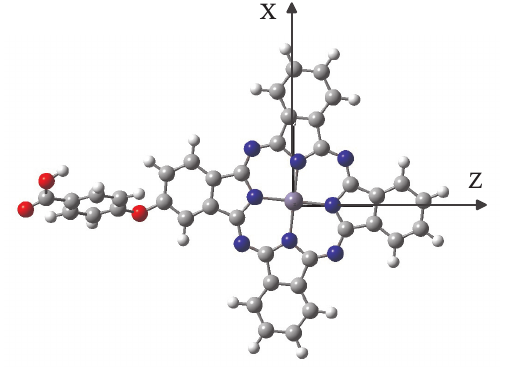
Figure 3. The polar molecular complex used: the zinc–phthalocyanine complex is composed of carbon (gray), hydrogen (white), oxygen (red), nitrogen (blue), and zinc (light blue) atoms. The complex is not planar; however, the phthalocyanine part of the complex is planar, coinciding with the zx -plane, as schematically